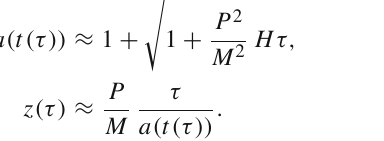
if M (cid:12) D (cid:12) H holds. In this very case, the non-rest- and rest-frame calculations of ˜ χ 3 agree with each other. Right: Numerical calcula- tion of (cid:7) ˜ p z ( t ) (cid:5) . The expectation value of ˜ p z computed in the non-rest frame tends to zero if M (cid:12) D (cid:12) H , which agrees with its expectation value computed in the rest